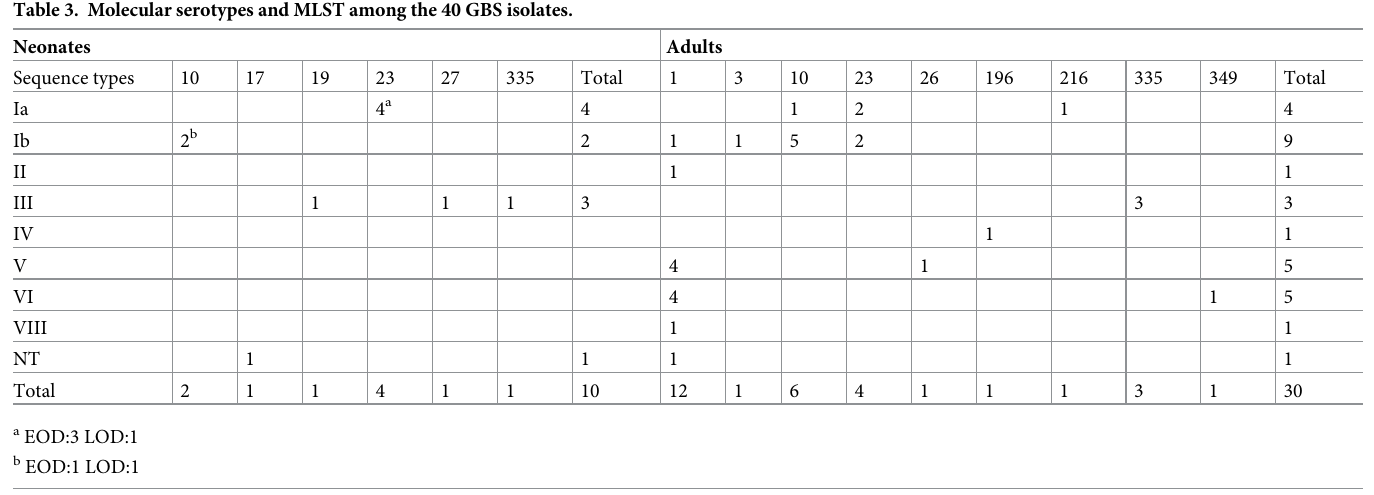
change of Ser-81 to Leu in the gyrA product, and Ser-79 to Phe or Tyr in the parC product. We observed point mutations in 11 isolates in gyrA and 13 isolates in parC . Eleven molecular sero- type Ib CC10 isolates with double mutations in gyrA and parC showed resistance to levofloxa- cin, although two isolates with a single mutation in just parC did not show resistance to levofloxacin (Fig 1). Regarding the other antibiotics, 18% (7/40), 15% (6/40), 10% (4/40), and 5% (2/40) of the strains were not susceptible to erythromycin, azithromycin, clarithromycin, and clindamycin respectively. Nine isolates had resistant genotypes: mefA (n = 3), ermA (n = 4), and ermB (n = 2). The relationship between macrolide resistance genes and MIC are shown in Table 5. Three of these isolates did not show high MICs for macrolide. Half of the isolates that were not susceptible to macrolides and clindamycin were isolated from neonates within the first week of life. Isolates that did not have these three resistant genotypes did not show a high MIC for macrolides. The relationships between the molecular serotype,